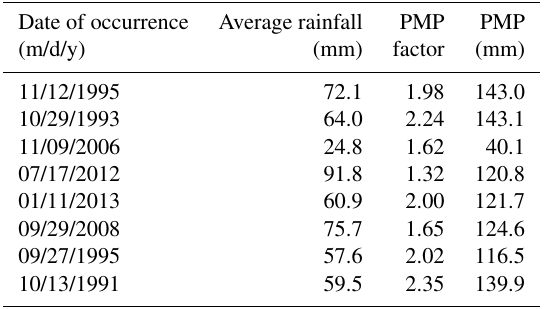
Figure 4. Depth–area–duration curve for the storm of September 2008 in the study